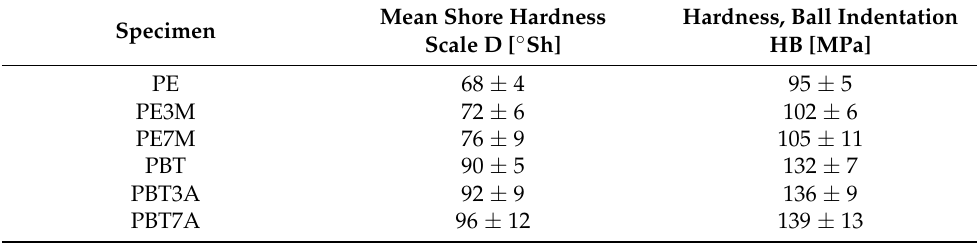
Table 2. Harnesses measured by the Shore durometer and the ball indentation method.